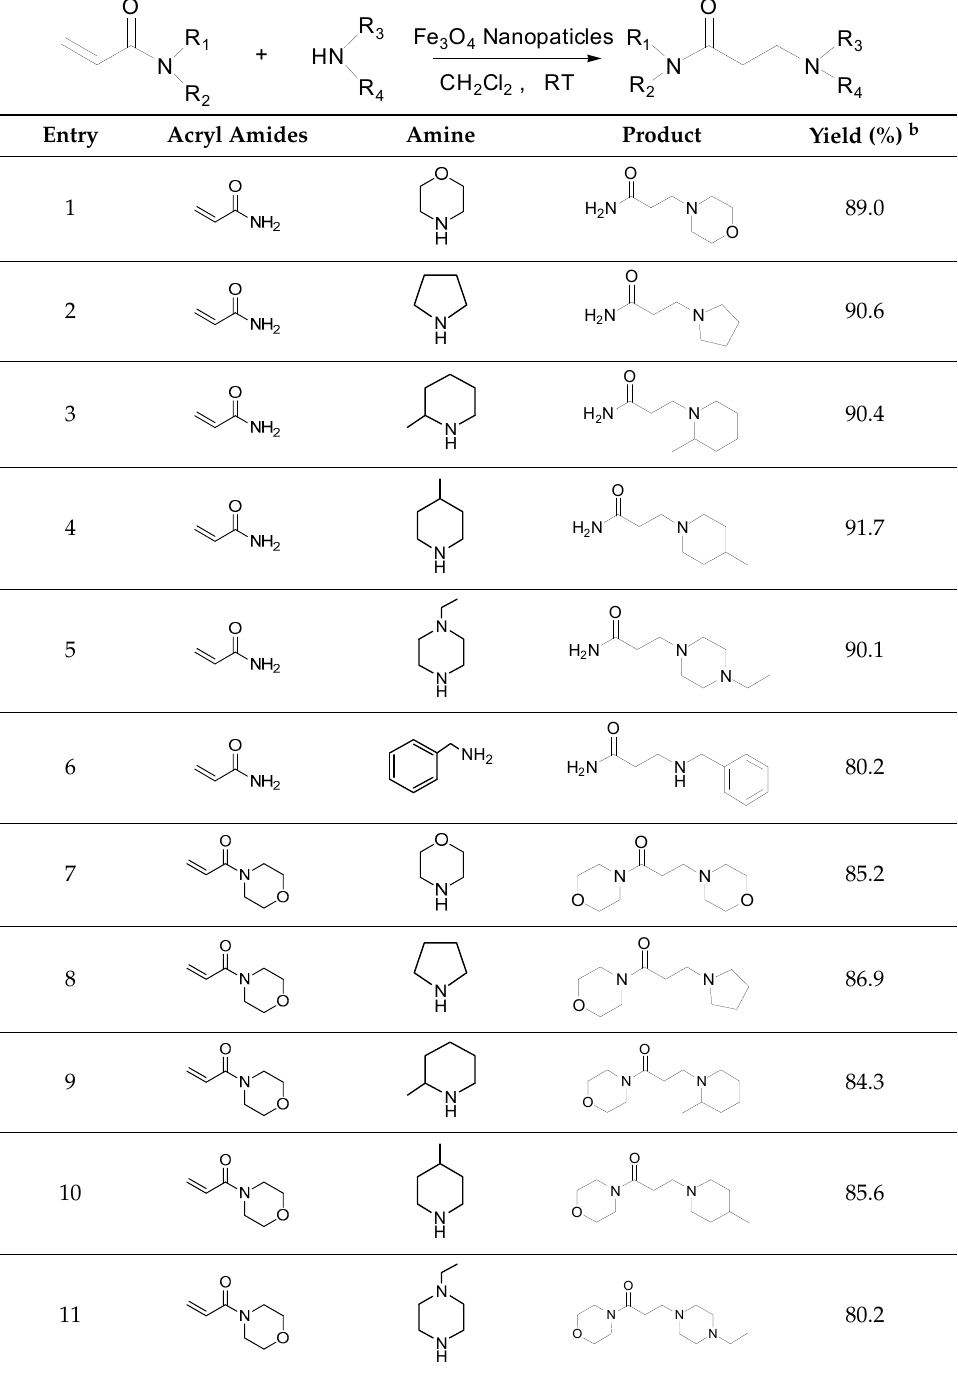
a Reaction conditions: acryl amides (2 mmol), amines (2 mmol), and catalyst (10 mol %) in 1 mL of CH 2 Cl 2 for 24 h at room temperature in a Schlenk tube. b Isolated yield. Such a catalytic ability of the magnetic Fe 3 O 4 nanoparticles ‐ based catalyst is not novel to amines, other common amines substrates can be performed too. In addition, all of them performed high isolated yield (Table 2, entries 1–16). The secondary amines such as morpholine (Table 2, entries 1, 7 and 13), pyrrolidine (Table 2, entries 2, 8 and 14), 2 ‐ methylpiperidine (Table 2, entries 3 and 9), 4 ‐ methylpiperidine (Table 2, entries 4, 10 and 15) and 1 ‐ ethylpiperazine (Table 2, entries 5 and 11) are efficient Michael donors and the yield is more than 80%. Furthermore, the primary amine (phenylmethanamine) also exhibit high reaction rate and yield, and the isolated yields are 80.2, 90.1 and 80.1, respectively (Table 2, entries 6, 12 and 16). In addition, this aza ‐ Michael addition reaction can also be carried out on the acyclic amines. The n ‐ butylamine and n ‐ propylamine (Table 2, entries 17